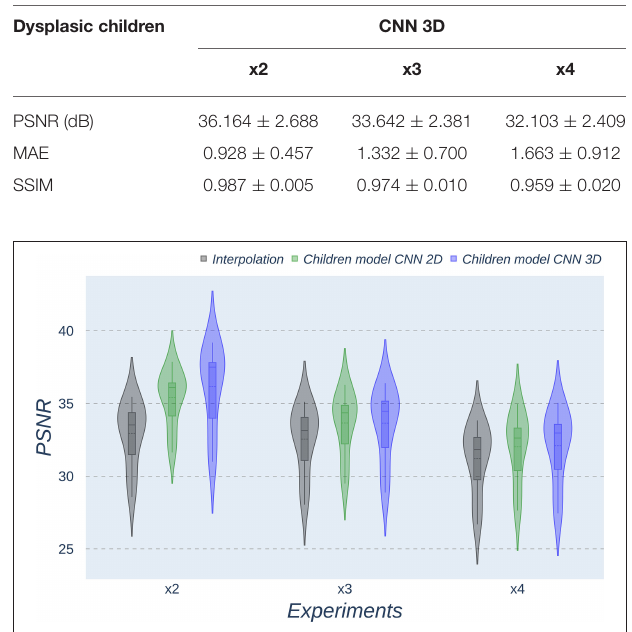
TABLE 7 | Results for different metrics and scaling factors among dysplasic children test set using 3D CNN method.